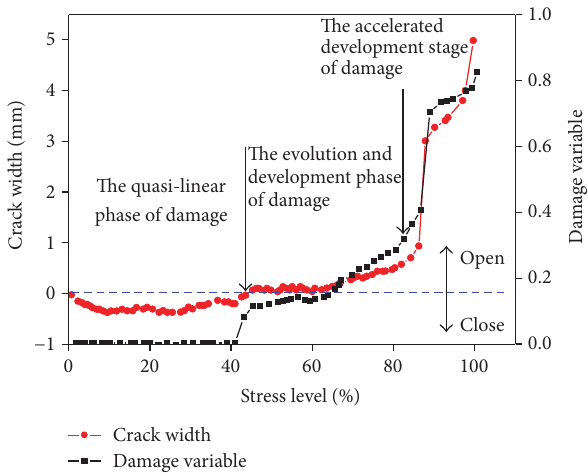
Figure 9: The evolution of crack width and damage variable [15].